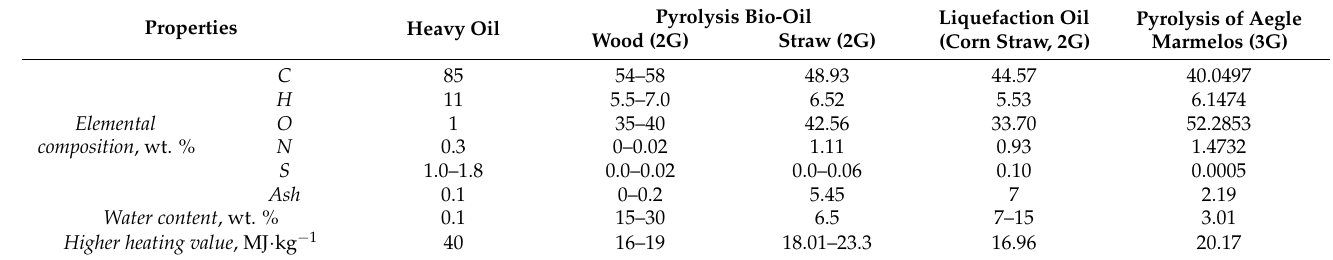
Table 1. Typical physicochemical properties of heavy, 2G pyrolysis, 2G liquefaction, and 3G oil [9–11]. Properties